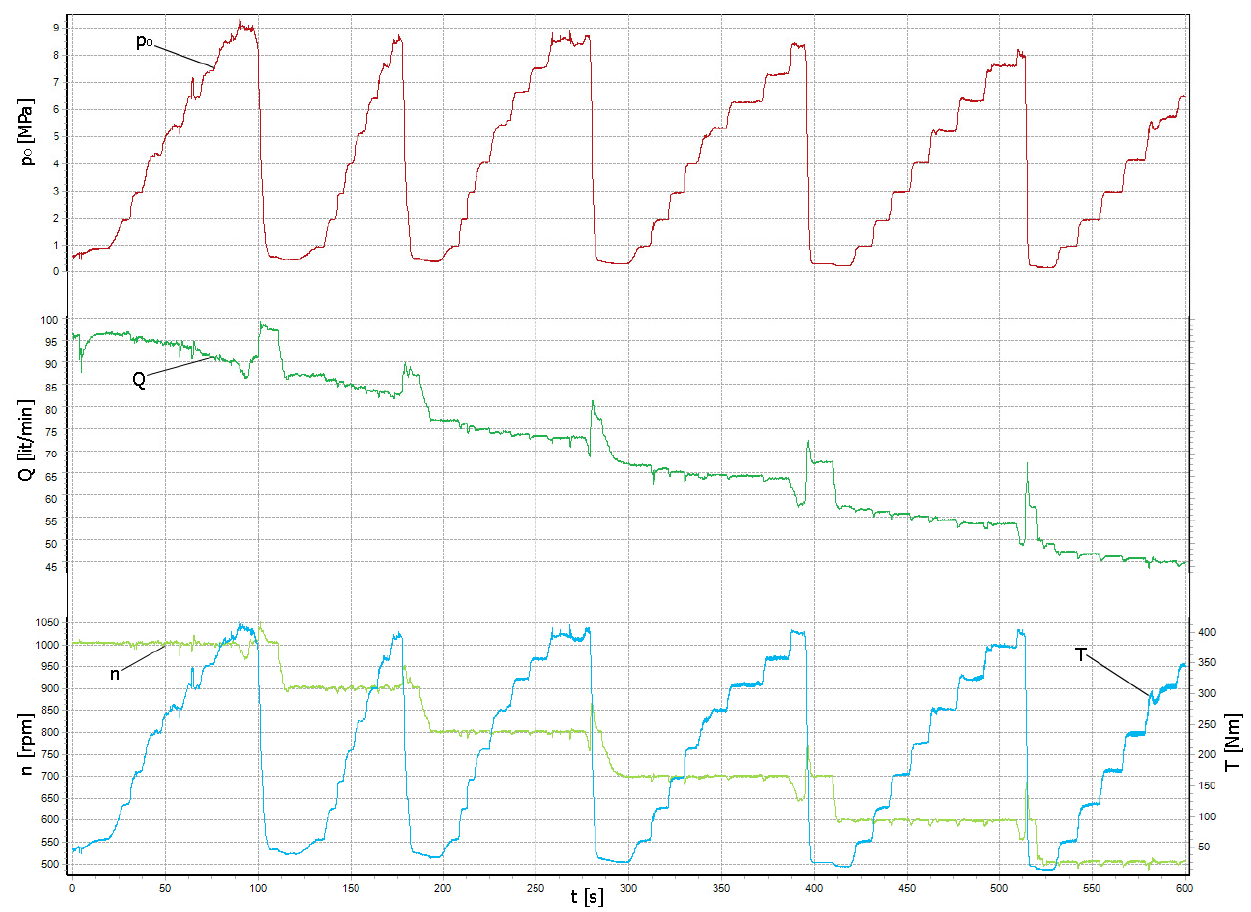
Figure 11. Summary diagram of the measured values of the operating parameters of the pump.